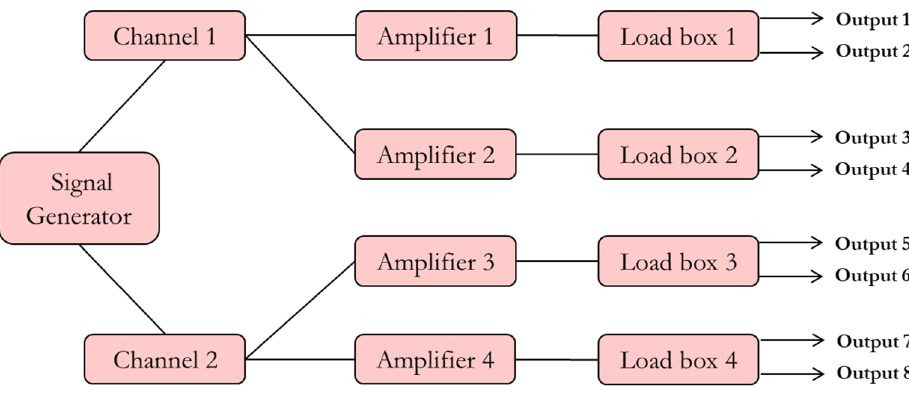
Figure 5. Power electronics system schematic.